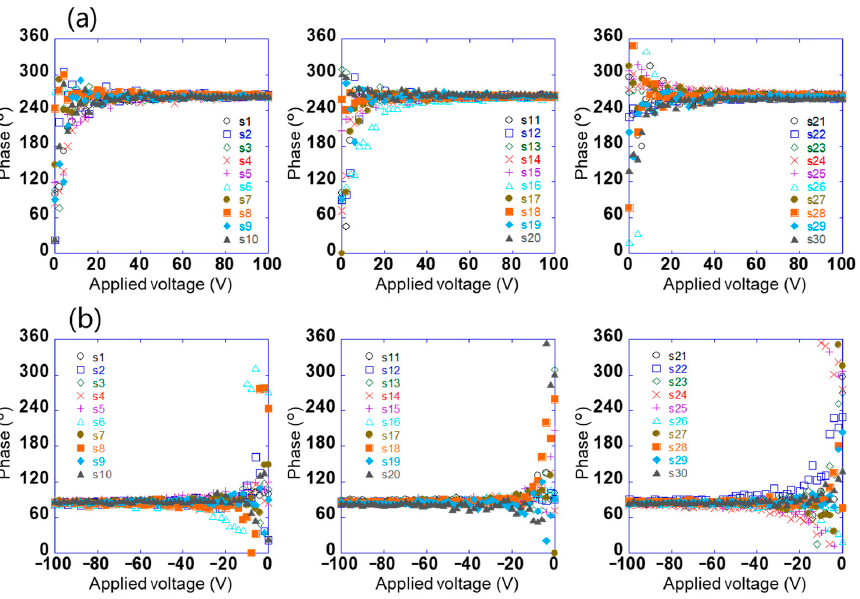
Figure 4. Relationship between voltage applied to test sample 1 in the range of ( a ) 0 to +100 V and ( b ) − 100 to 0 V and the phase of the voltage detected using each sensor (s 1 –s 30 ).